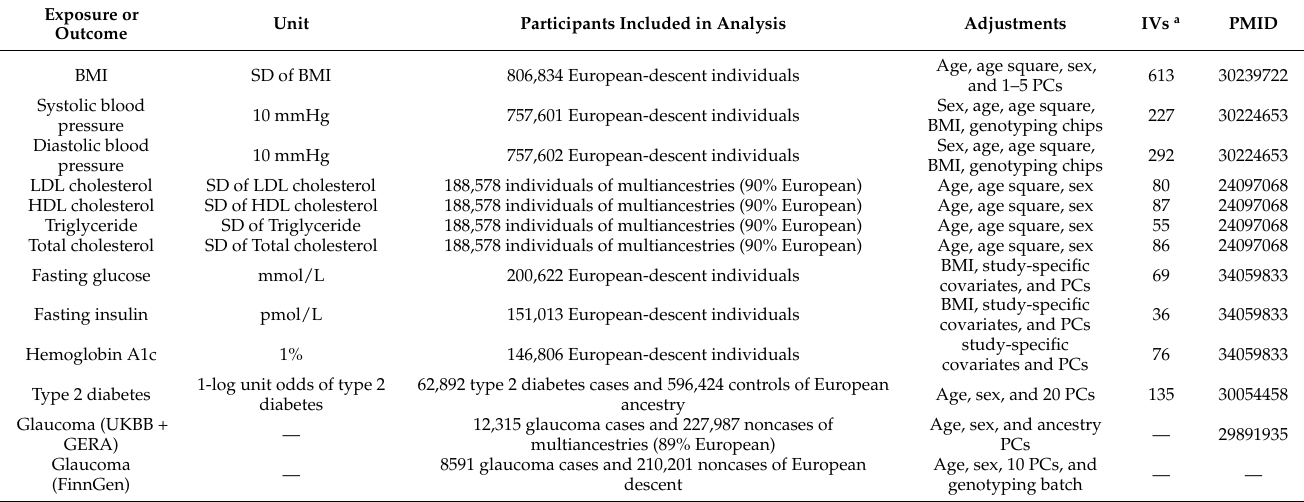
Table 1. Overview of the data sources used in the Mendelian randomization